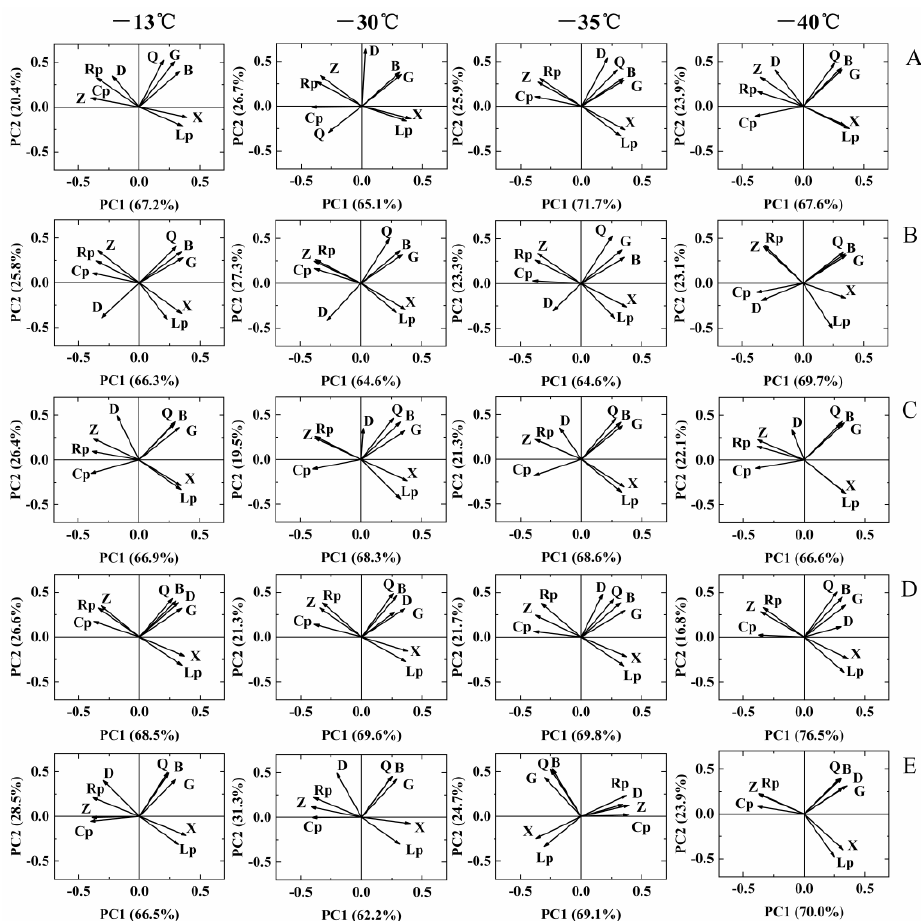
Figure 7. Principal component diagrams of dielectric parameters of sea buckthorn at different freezing temperatures and freezing times. (( A ), 15 d; ( B ), 30 d; ( C ), 45 d; ( D ), 60 d; ( E ), 75 d). Table 1. Correlations between seven quality attributes and dielectric parameters of sea buckthorn fruit during